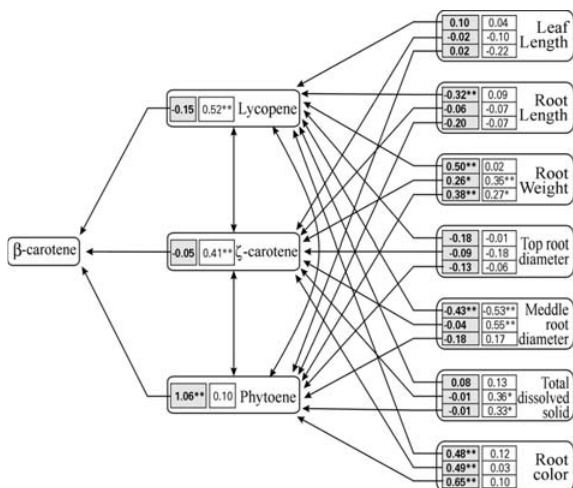
Figure 2 - Causal diagrams reflect the interrelationships between β -caro- tene and the primary explanatory variables (lycopene, ζ -carotene and phytoene) and the secondary explanatory variables (leaf length, root length, root weight, top and middle root diameter, total dissolved solids and root color) for two F 2 carrot populations (B493 x QAL and Brasilia x HCM). The path coefficient ( $ p) for cells with a black background are for the B493 x QAL population while a white background shows the values for the Brasilia x HCM F 2 population. significant by the t-test (n-2 degrees of freedom) at 1%. ** significant by the t-test (n-2 degrees of freedom) at